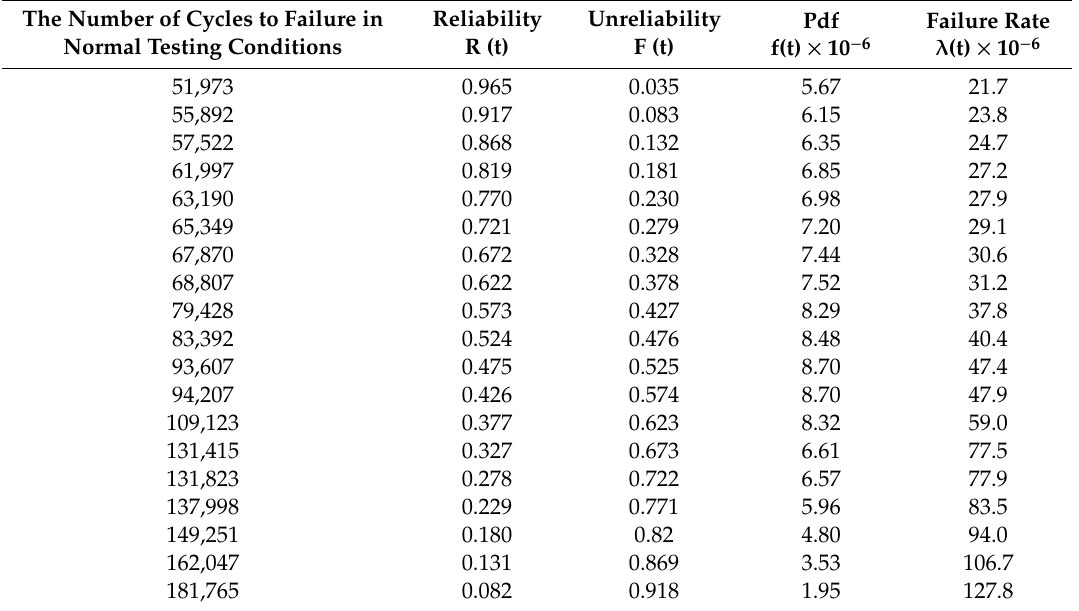
Table 5. The dependence of the reliability indicators as function of the number of cycles to failure in normal testing